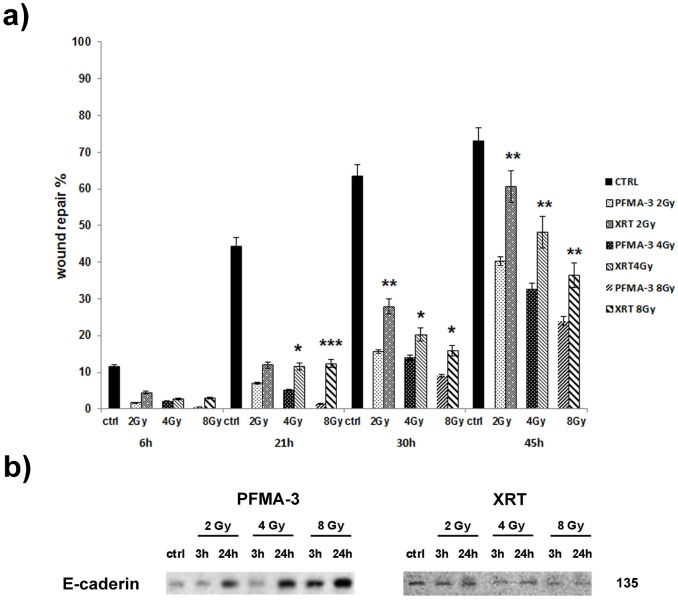
PFMA-3 affected SK-Mel28 migration abilities more than XRT.a) Cell migration behaviour was evaluated during performance of a wound-healing assay after treatment with 2 Gy, 4 Gy and 8 Gy PFMA-3 and XRT. Data were representative of three independent experiments performed in quadruplicate. ctrl, control cells. Asterisks indicated statistically significant differences (*P <0.05, **P <0.005, ***P <0.0005). b) Western blot analysis documenting E-cadherin levels modulation in PFMA-3 and XRT irradiated samples. b-actin loading control was not shown. ctrl, control cells.